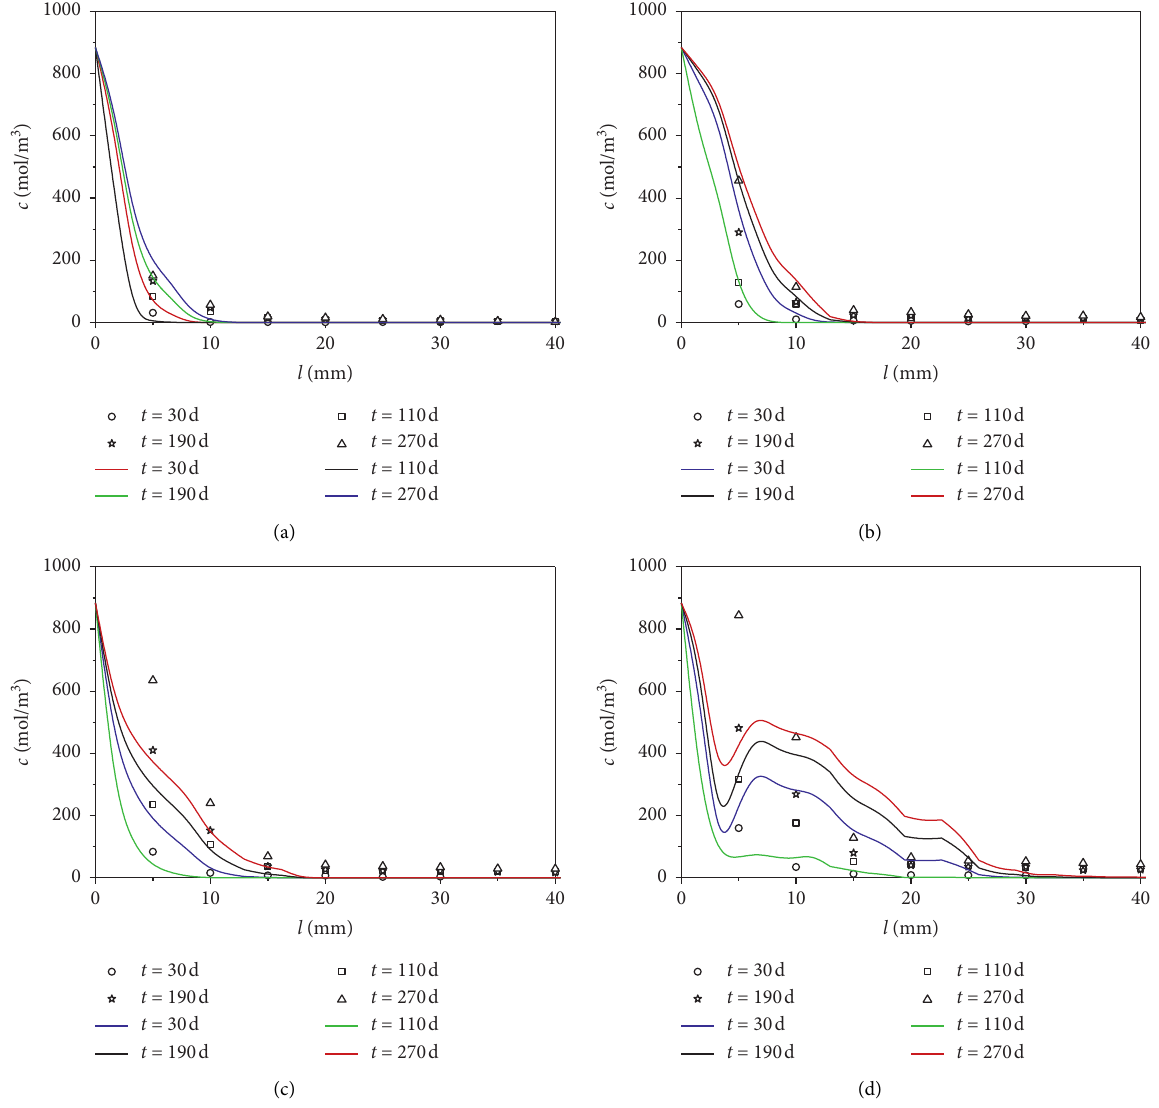
Figure 9: Numerically calculated curves of chloride ion concentration c with depth l compared with experimental values. (a) n � 0. (b) n � 30. (c) n � 60. (d) n �